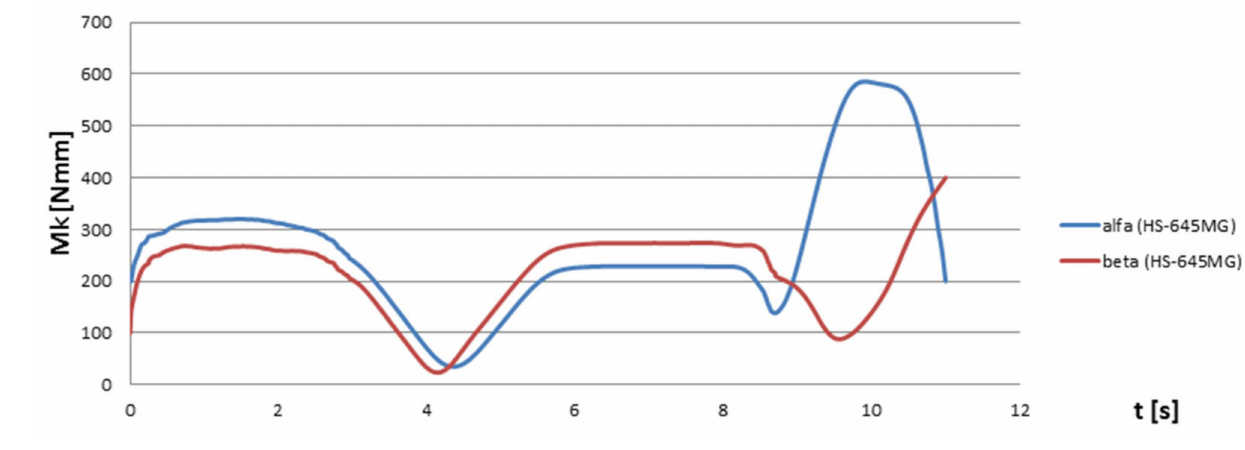
Figure 13. Graph of rotational actuator torques.